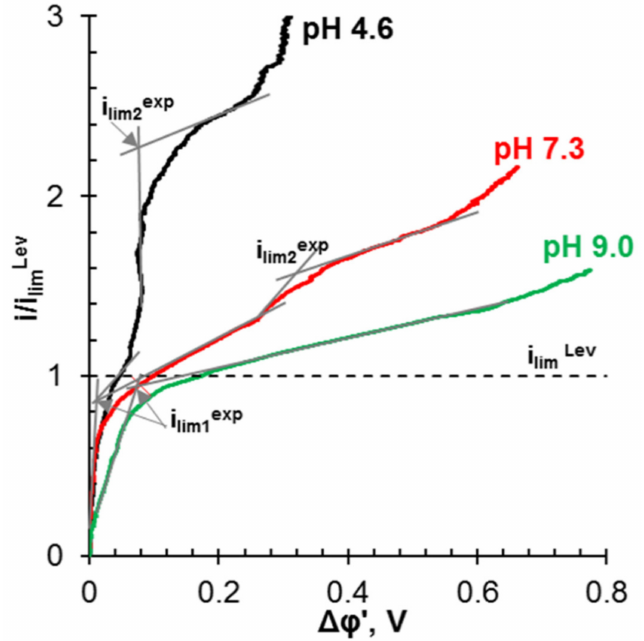
Figure 20. Current-voltage curves of an AX membrane (Astom, Yamaguchi, Japan) in 0.02 M Na x H (3 − x) PO 4 solutions with pH 4.6, 7.3, and 9.0. The currents are normalized to i limLev , calcu- lated for each solution using Equations (1)–(3). The ohmic component is subtracted from the total potential drop. Reproduced with permission from [207]. Copyright 2022